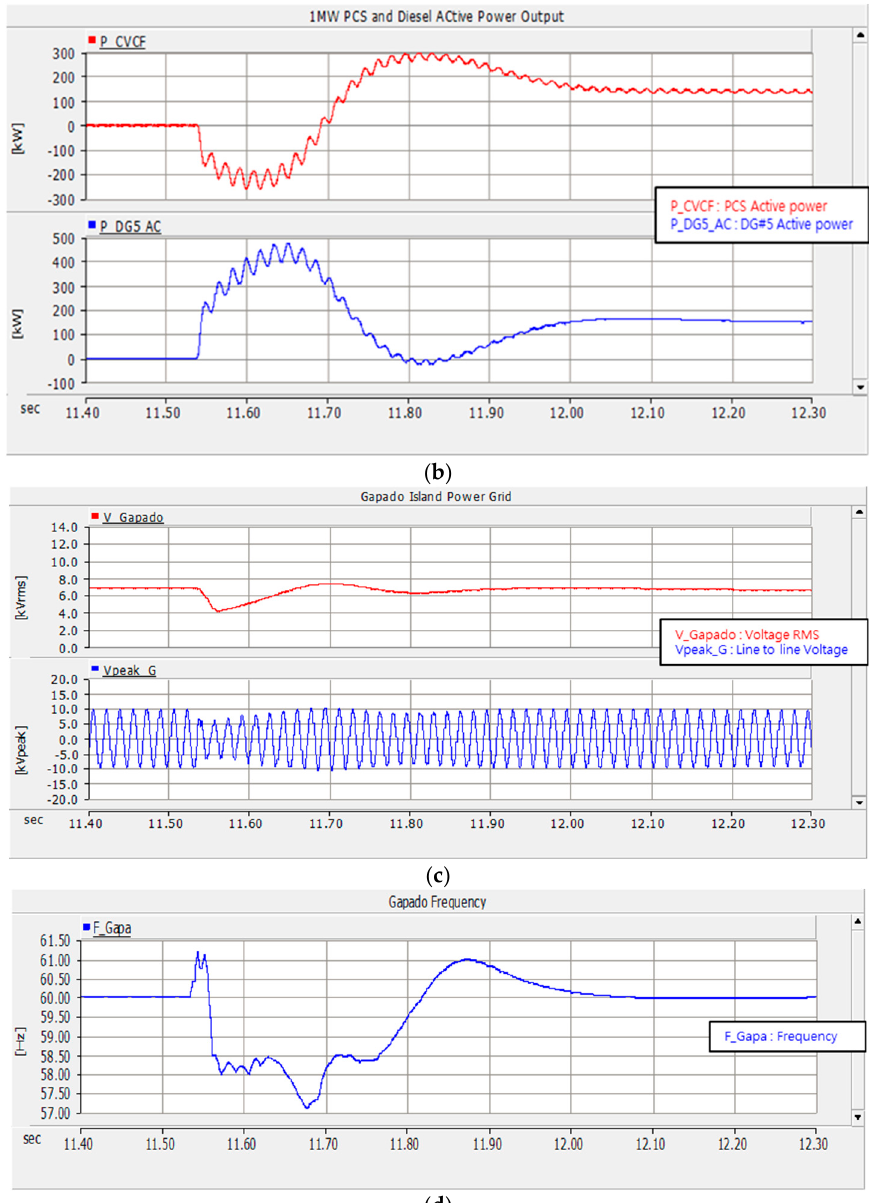
Figure 12. ( a ) Active power; ( b ) active power of 1 MW PCS; ( c ) voltage; ( d ) frequency; simulation results of Gapado Island when under diesel generator dropout.